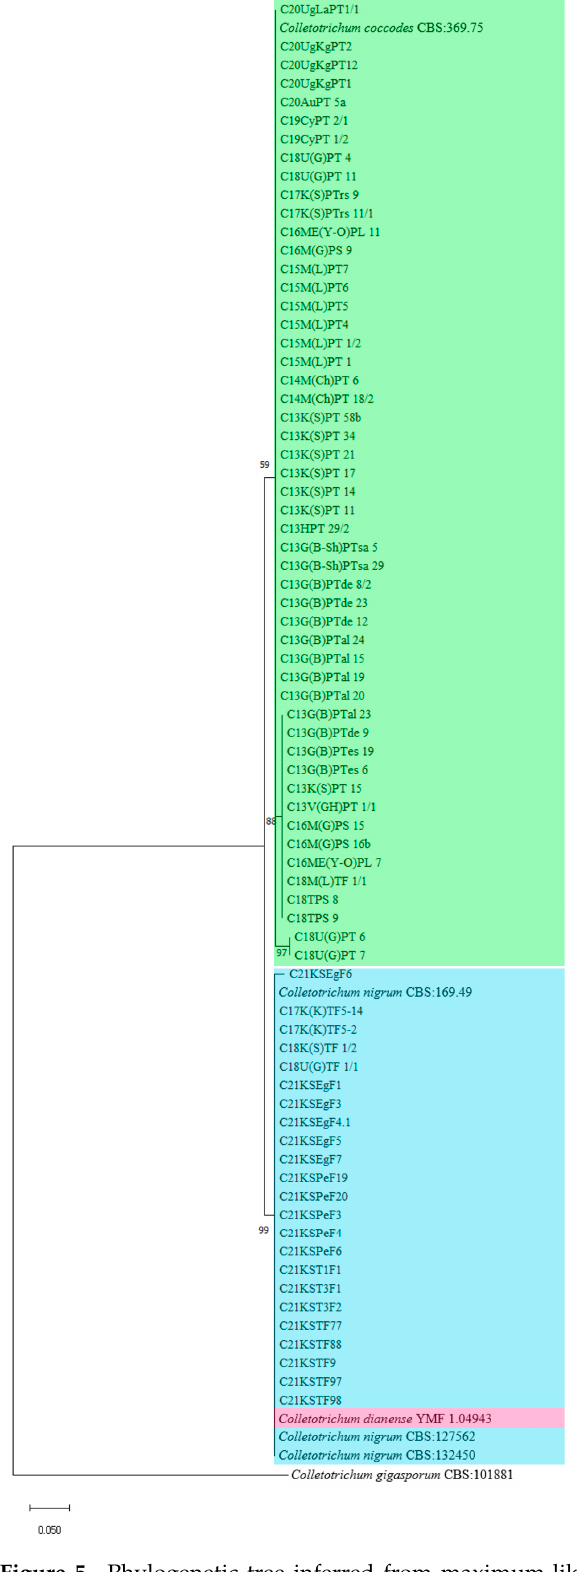
Figure 5. Phylogenetic tree inferred from maximum-likelihood analysis of the glyceraldehyde-3-phosphate dehydrogenase intron alignment. Bootstrap 1000 replicates. The confidence values are indicated at the branches. Green indicates C. coccodes clade, blue indicates the C. nigrum clade, and red marks C. dianense type species.